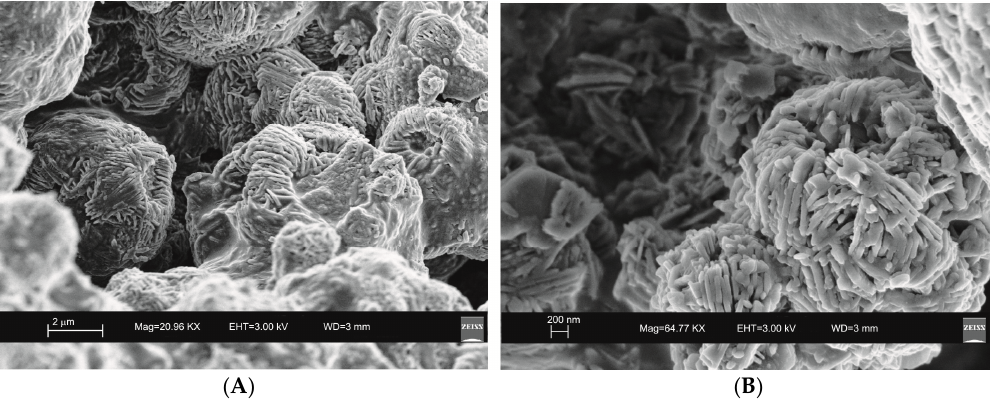
Figure 5. SEM images of sodaline characterizing the sample 6 months after the ultrasonic water bath treatment. ( A ) overview of zeolites formed; ( B ) detail of sodalite crystal.